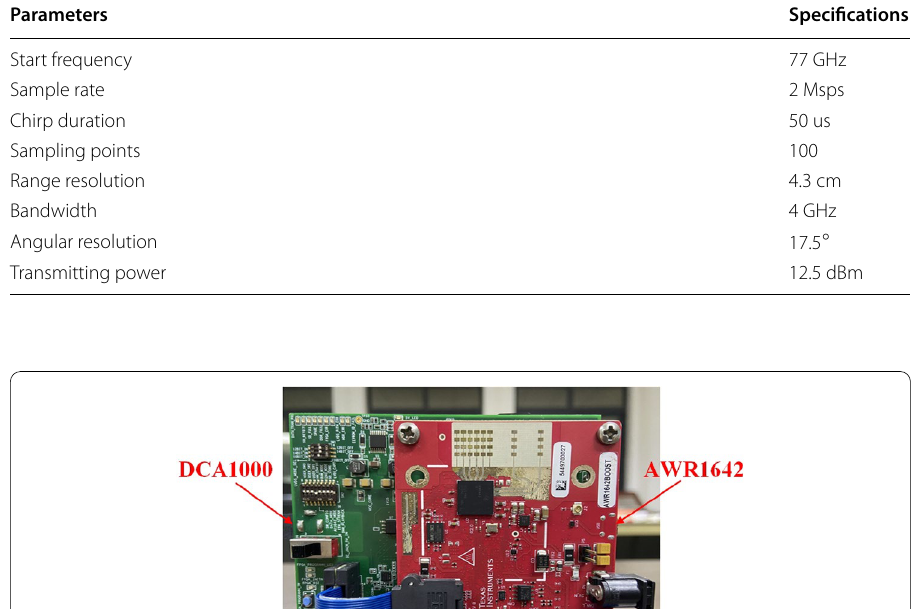
Table 1 Parameters setting for multi-human target vital sign